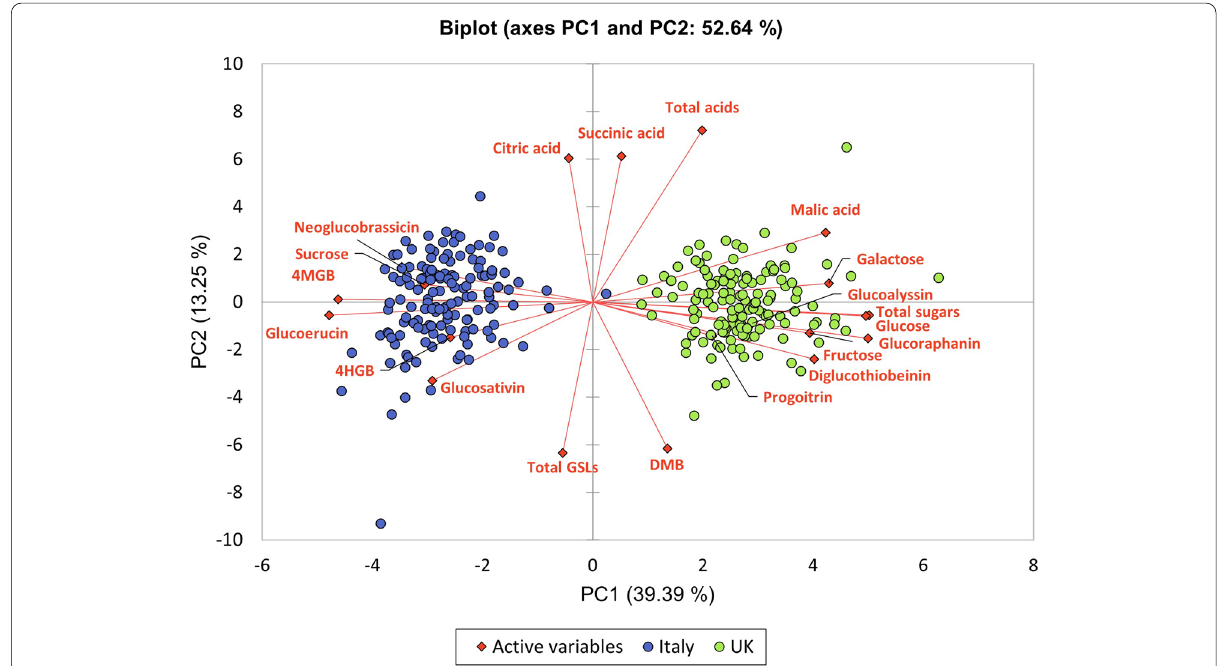
Fig. 5 Principal Component Analysis biplot representing 52.64% of metabolite variance across the Eruca vesicaria subsp. sativa mapping populations grown in Italy and the UK. PC1 and PC2 explain 39.9 and 13.25% of the total variation between samples, respectively. Eigenvalues for PC1 and PC2 were 7.88 and 2.65, respectively. Abbreviations: DMB, dimeric 4-mercaptobutyl GSL; 4HGB, 4-hydroxyglucobrassicin; 4MGB,